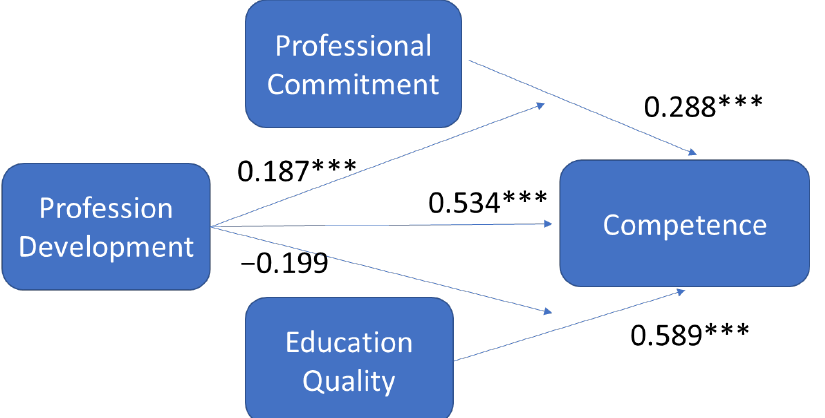
Figure 2. Results of regression model analysis. *** p < 0.001.